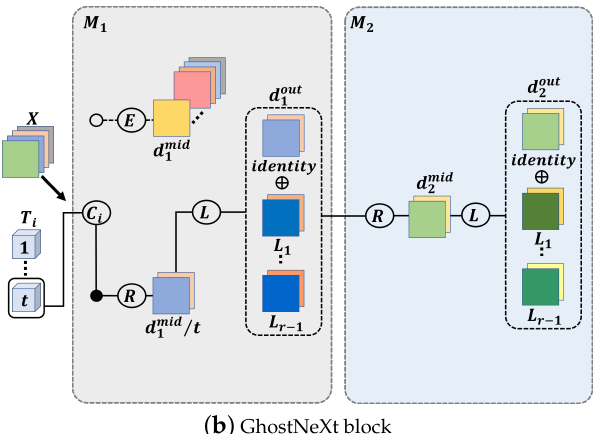
Figure 1. ( a ) The i -th GhostNet block. E , R , and L denote the channel expansion operation, reduction operation, and linear transformation function, respectively. The input X is expanded through E and L , where the difference between the output channel d out of the first module and X is limited up to six 1 times. d out is the input of the second module and is reduced up to 12 times through R . ( b ) The i -th 1 GhostNeXt block with the controller C i . T i denotes the set of channel reduction ratios of the i -th block. C i selects t , one of the ratios in T i to perform one of the channel operations E and R . If R is selected, d mid is reduced by t and, if E is selected, it leads to the existing module configuration. Through L , the 1 output channel d out of the first module is generated by performing r − 1 linear transformation and 1 one identity mapping. We use the channel operation R in the second module.